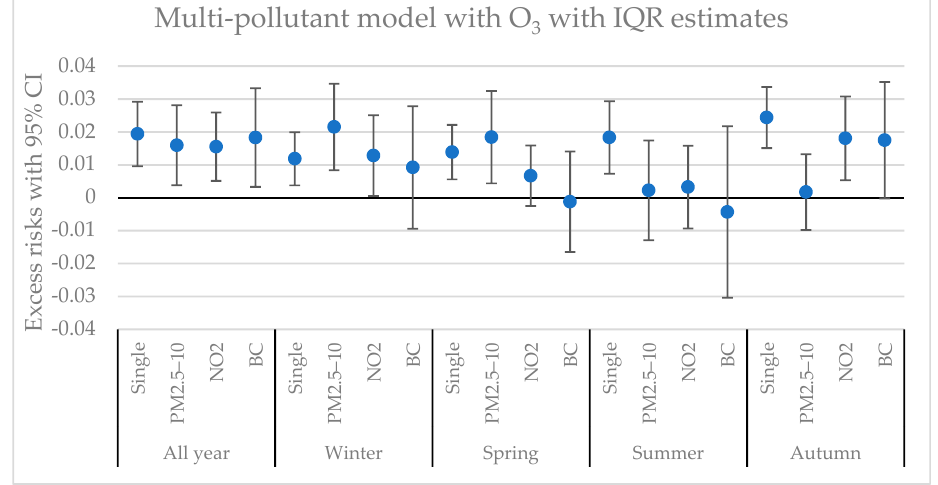
Figure 6. Estimated change in daily mortality with 95% CI (lag02) for an IQR increase in the concentrations of O 3 . The calculations are divided into all year and four different seasons. The excess risks are divided into single ‐ pollutant estimates and multi ‐ pollutant estimates with PM 2.5–10 , NO 2 and BC included in the calculations.